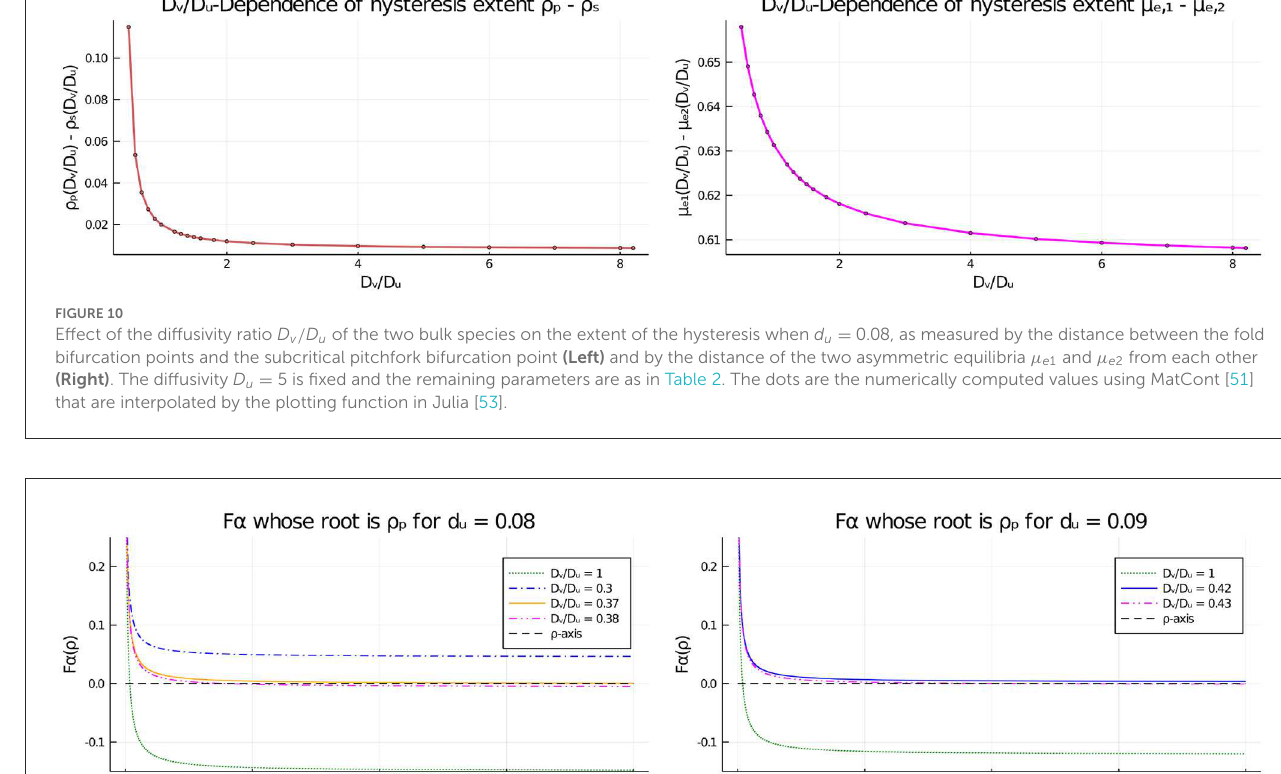
0.08 (Left) and d u 0.09 (Right) . The numerical results show that = =